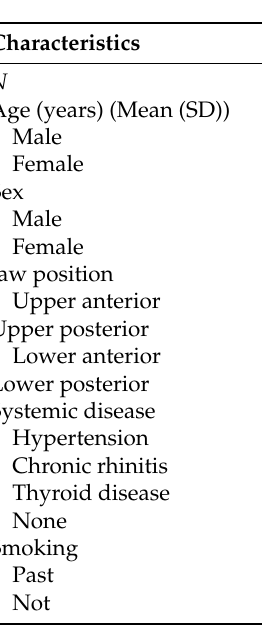
Table 1. General